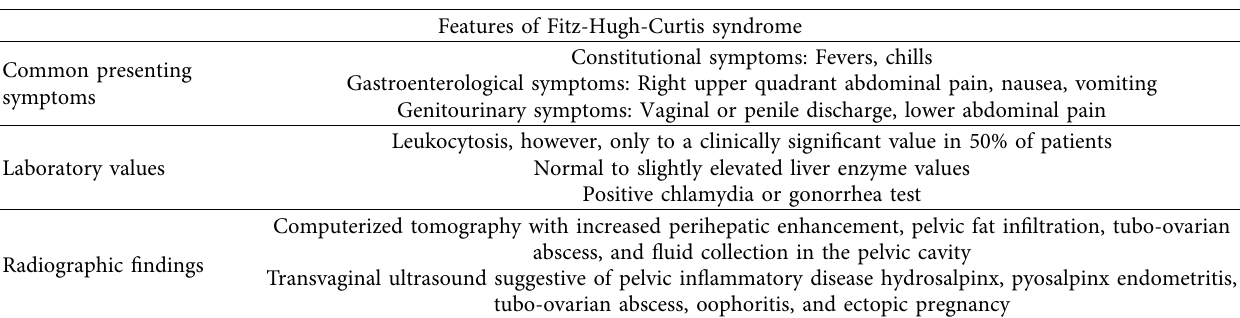
Table 1: Common features of Fitz-Hugh-Curtis syndrome, including symptoms, laboratory values, and radiographic findings [1]. Features of Fitz-Hugh-Curtis syndrome